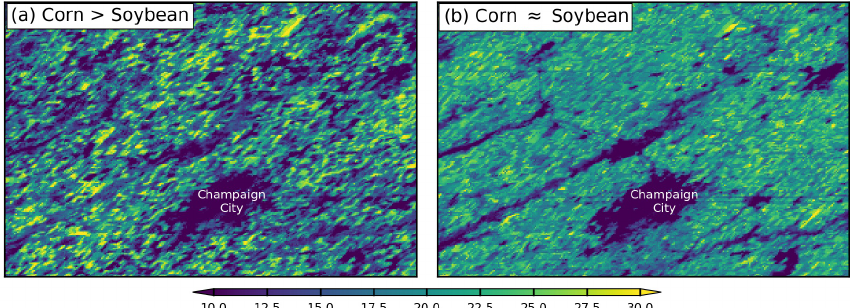
Figure 13. GPP (gCm − 2 d − 1 ) in a 50 × 75km 2 area in Champaign County, Illinois (red marker in Fig. 12a), on (a) 10 July 2020 and (b) 20 August 2020. The maps are shown with the sinusoidal projection.